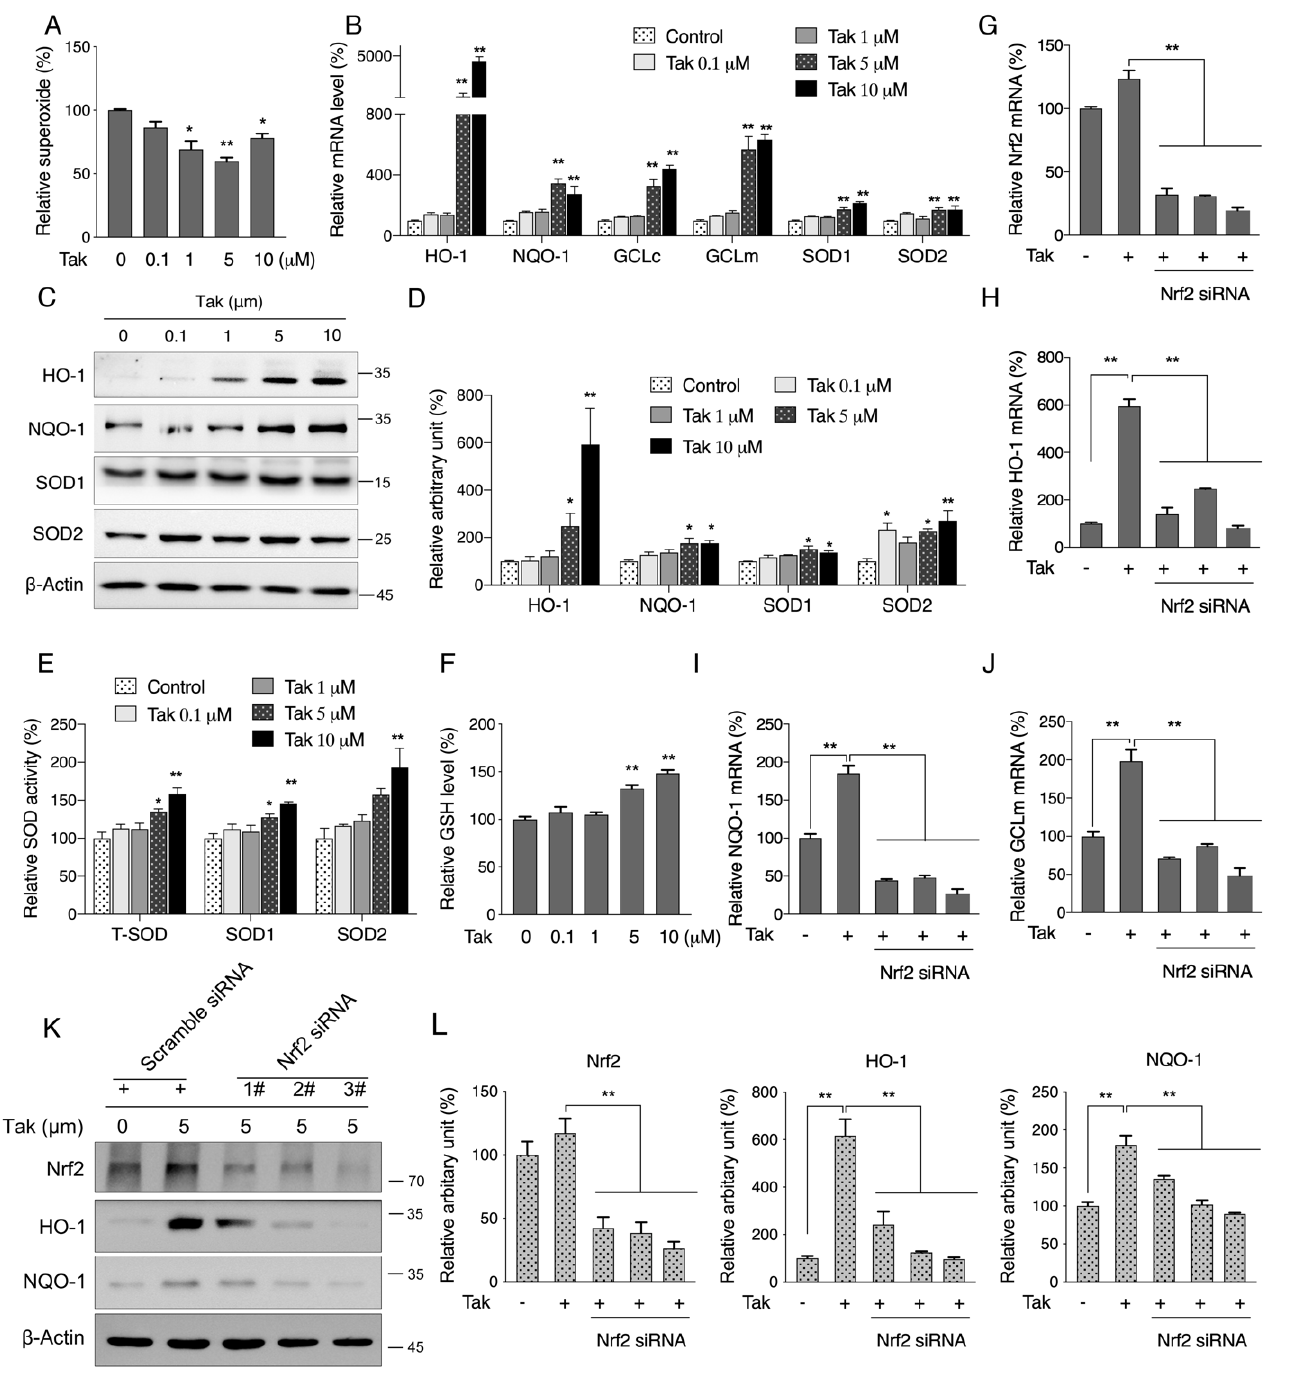
Figure 3. Tak improves redox status by activating phase II enzymes. ( A ) HT22 cells were treated with Tak at concentrations of 0, 0.1, 1, 5, and 10 µ M for 24 h, and mitochondrial superoxide was analyzed. HT22 cells were treated with Tak for 6 h for analysis of phase II enzymes mRNA expression ( B ), and 24 h for analysis of protein expression (( C ): western blot images; ( D ): statistical analysis), SOD activities ( E ), and GSH level ( F ). HT22 cells were treated with three pairs of specific Nrf2 siRNA for 48 h followed by 5 µ M Tak treatment for 6 h; the mRNA expression levels of Nrf2 ( G ), HO-1 ( H ), NQO-1 ( I ), and GCLm ( J ) were analyzed by qRT-PCR. HT22 cells were treated with three pairs of specific Nrf2 siRNA for 48 h followed by 5 µ M Tak treatment for 24 h; the protein levels of Nrf2, HO-1, and NQO-1 were analyzed by western blot (( K ): western blot images; ( L ): statistical analysis). The values are presented as the mean ± S.E.M. from at least three independent experiments. * p < 0.05 and ** p < 0.01 vs. the control or between the connected